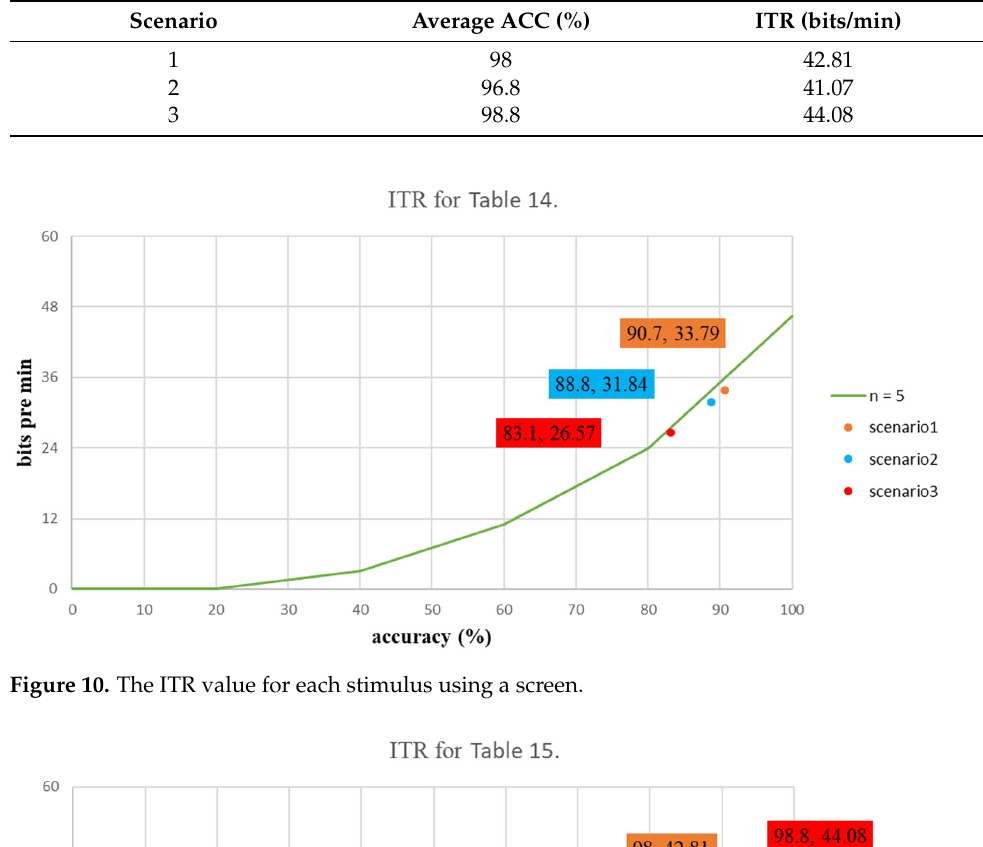
Table 15. The average accuracy for the three scenarios using MR goggles with CCA classifier.